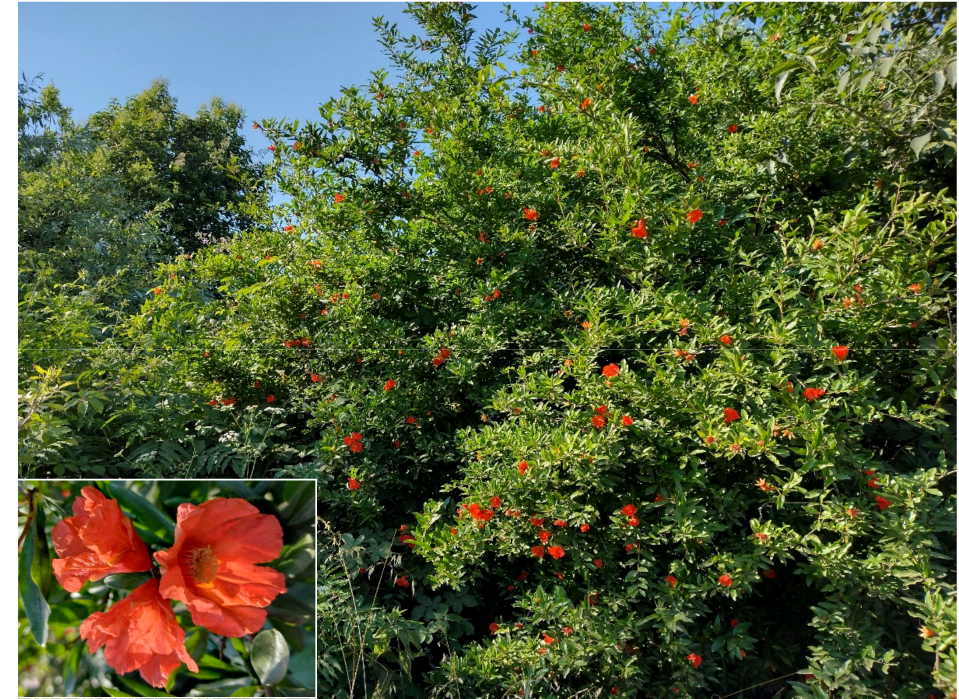
Figure 56. Punica granatum in Caffarella